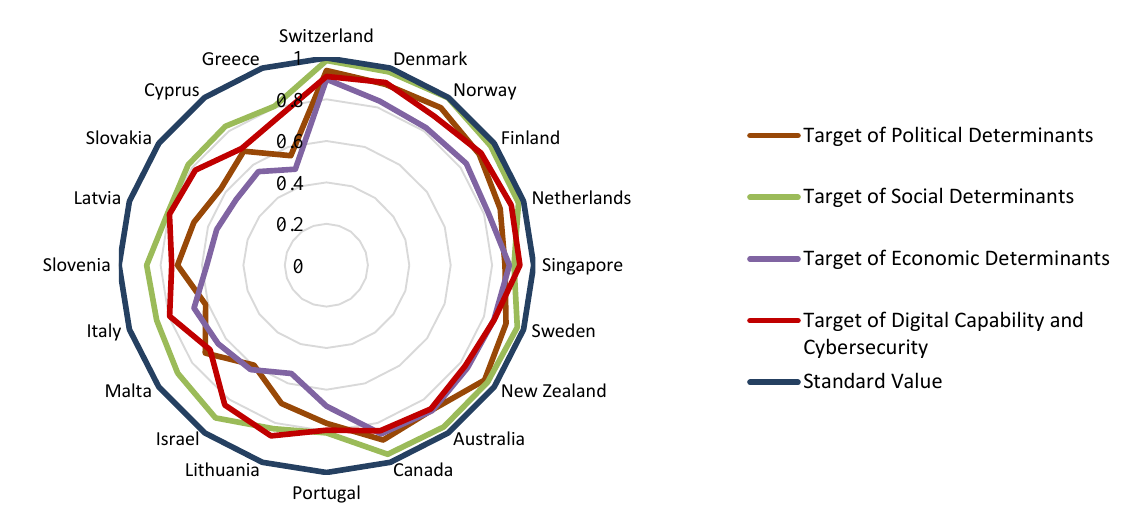
Figure 2. The values of composite targets of economic, social, political and digital capability and cybersecurity dimensions for developed countries. Source: Authors’